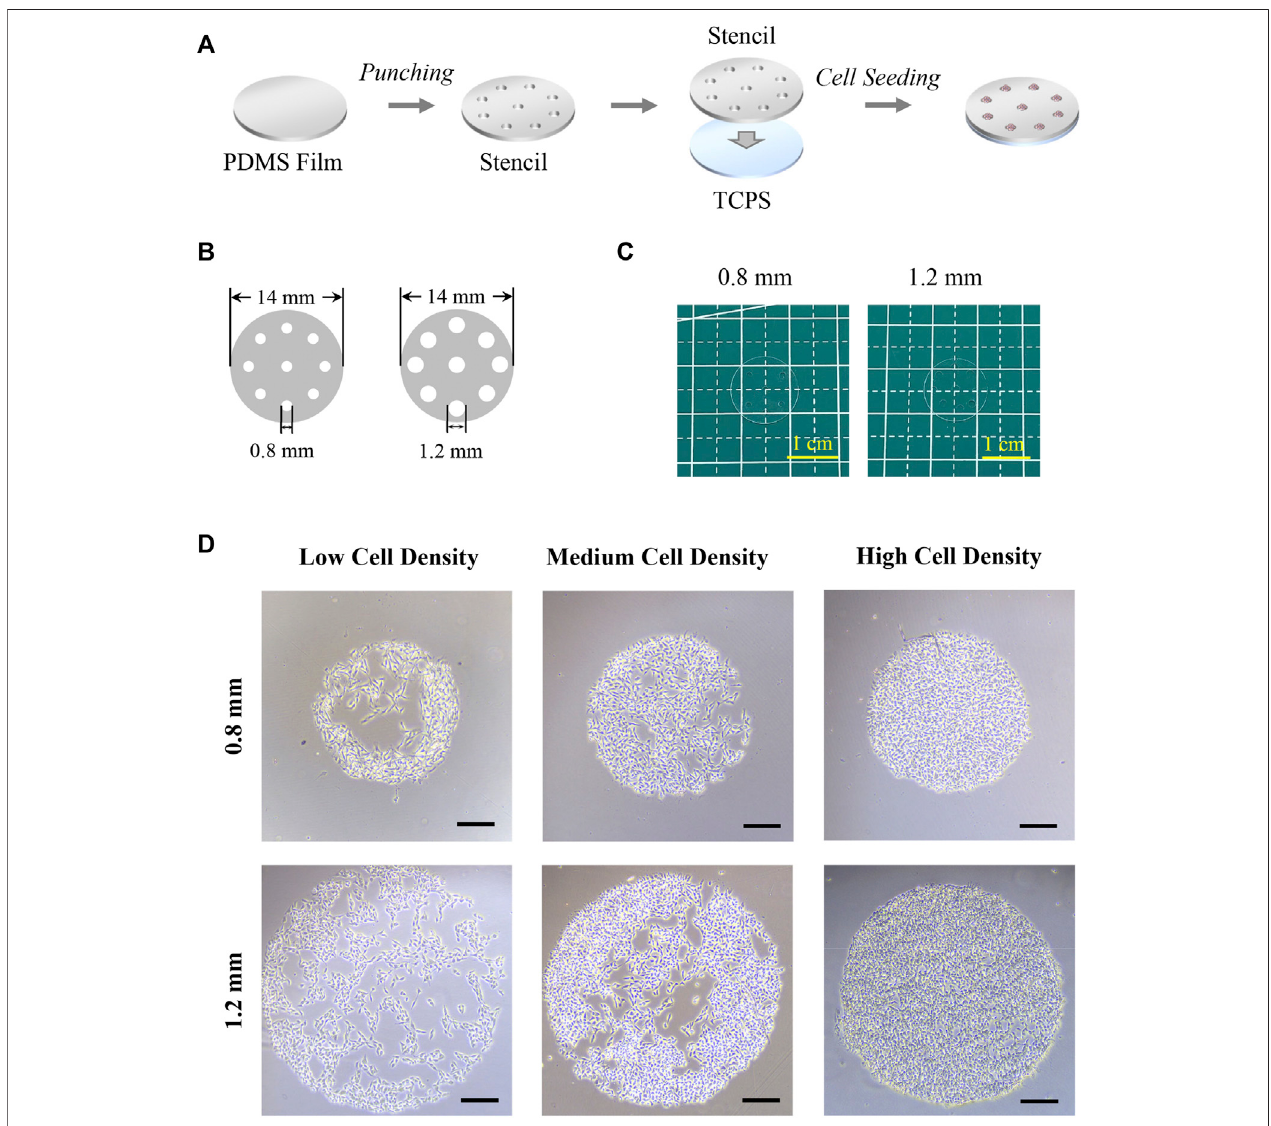
FIGURE1| PreparationofPDMSstencilsandmorphologyofmicropatternedcolonies. (A) SchemeofPDMSstencil ’ spreparationandapplicationincellculture. (B) Illustration of PDMS stencils ’ structure. (C) Photography of PDMS stencils. (D) Microscopic images of micropatterned melanoma colonies. Scale bar: 200 μ m.